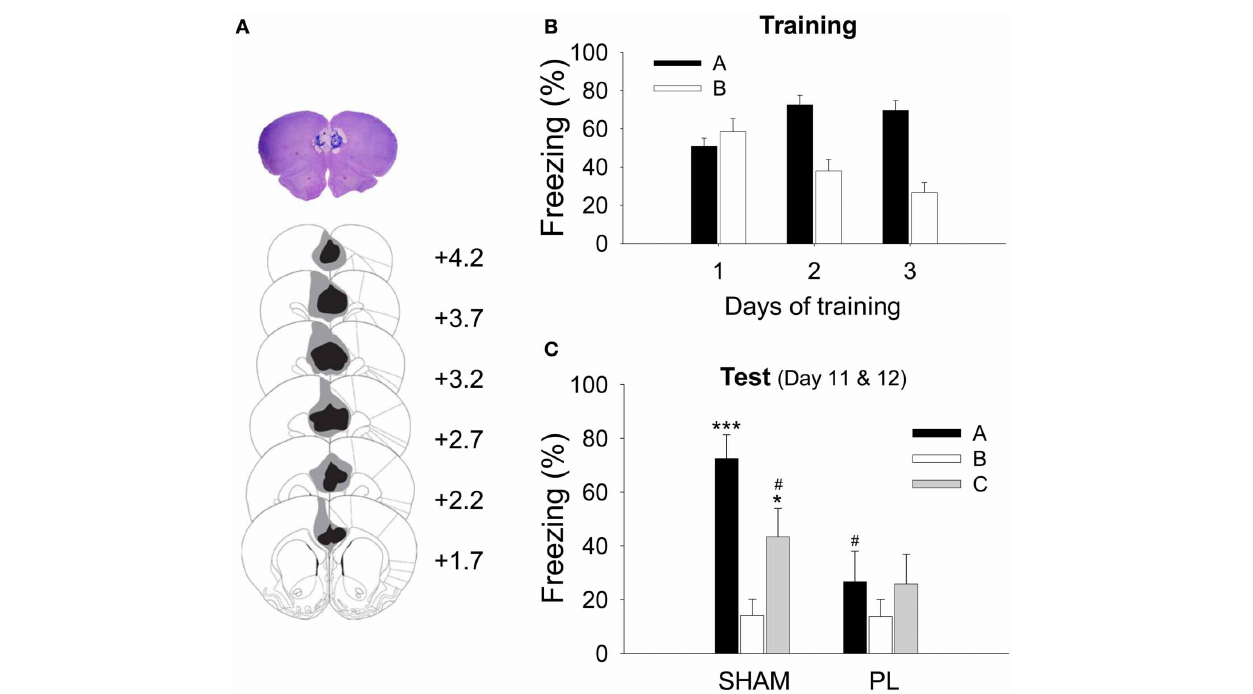
FIGURE 2 | Histological verification of the PL lesion and acquisition of CDFD. (A) High-resolution scan of a cresyl-violet-stained coronal section shows a representative PL lesion (top), and the reconstruction shows the extent of the electrolytic lesion (bottom). The gray shading depicts the largest and the black depicts the smallest lesion on the matching coronal sections from an atlas (Paxinos and Watson, 1998). (B) During training, all animals